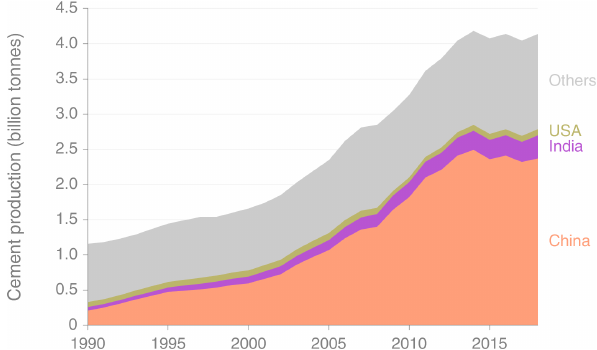
Figure C2. Production of cement by country, 1990–2018 (van Oss, 1994–2019; OEA, 2019; USGS,